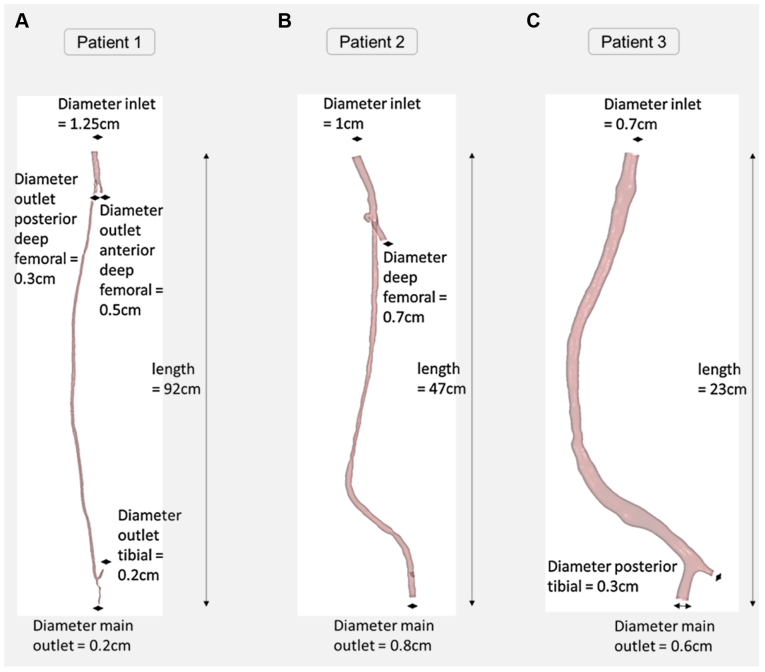
Summary of the geometric characteristics of patients analyzed in the study. A, Patient 1, femoral-distal bypass. B, Patient 2, femoral-popliteal bypass. C, Patient 3, femoral-popliteal bypass.